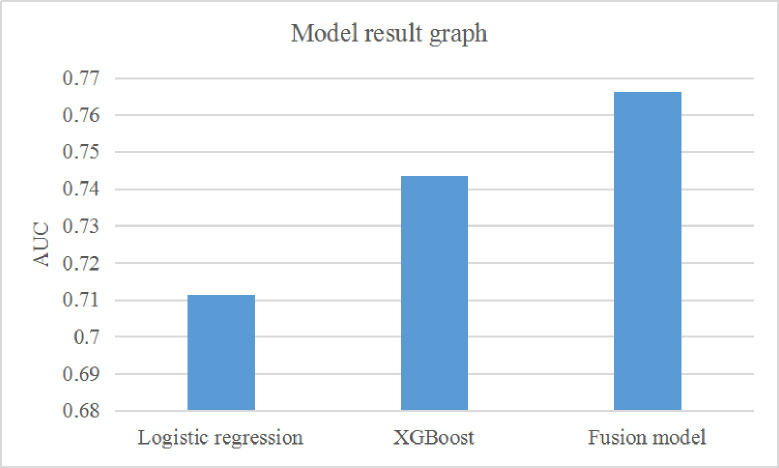
Single model and fusion model results.